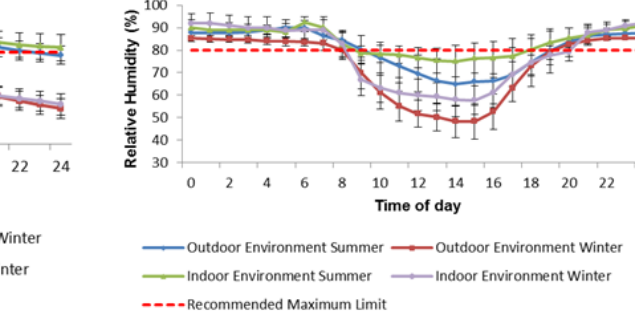
Figure 3. Average variation and standard deviation of the hourly mean values of (a) air temperature (tair) in °C and (b) relative humidity (RH), in %, of the air inside the closed compost-bedded pack barn (CBP), equipped with the EACS - Adiabatic Evaporative Cooling System, and in the external environment, throughout the experimental period of summer and